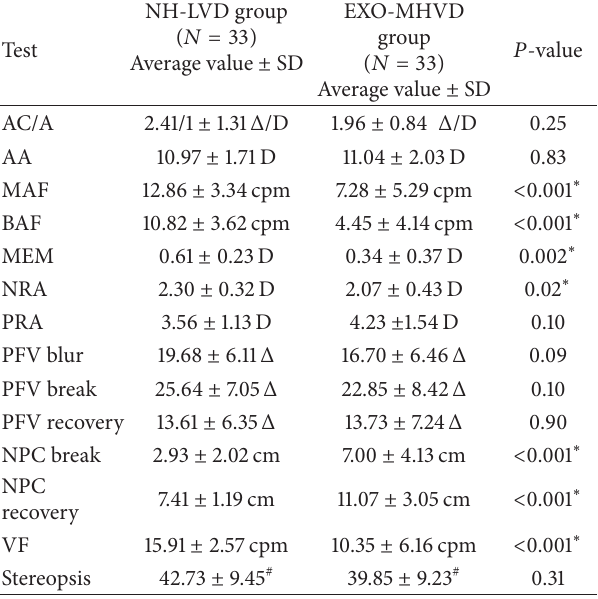
Table 2: Comparison of samples between both groups of